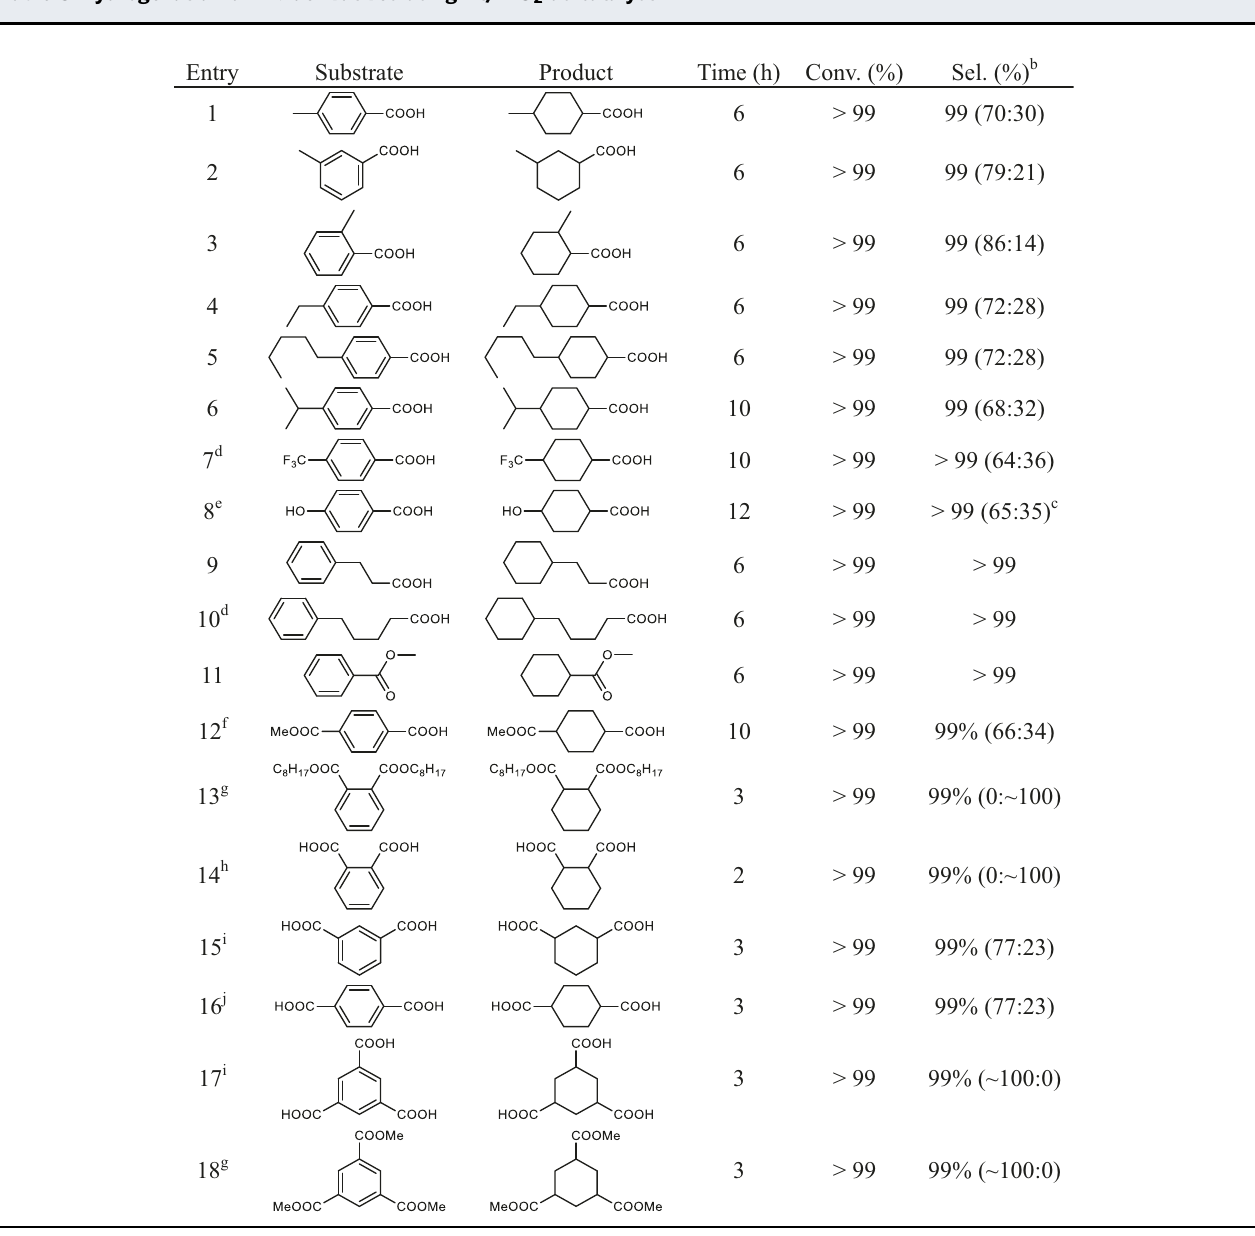
Table 3 Hydrogenation of BA derivatives using Pt/TiO 2 as catalyst a .